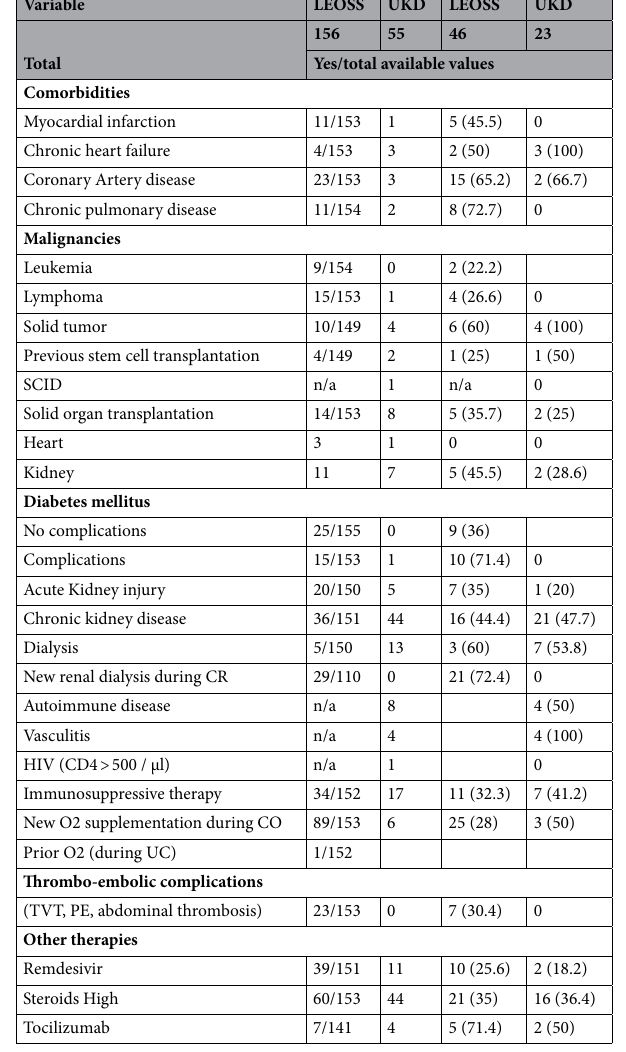
Table 2. Characteristics of LEOSS and UKD patients with CP